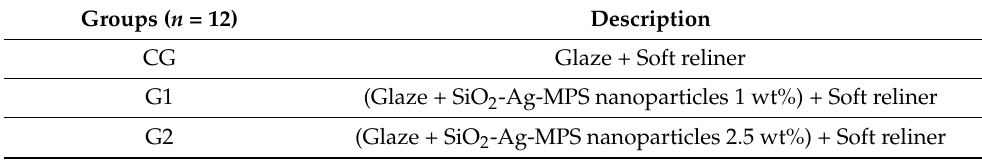
Table 1. Division of experimental groups according to the concentration of SiO 2 -Ag-MPS nanoparti- cles for the